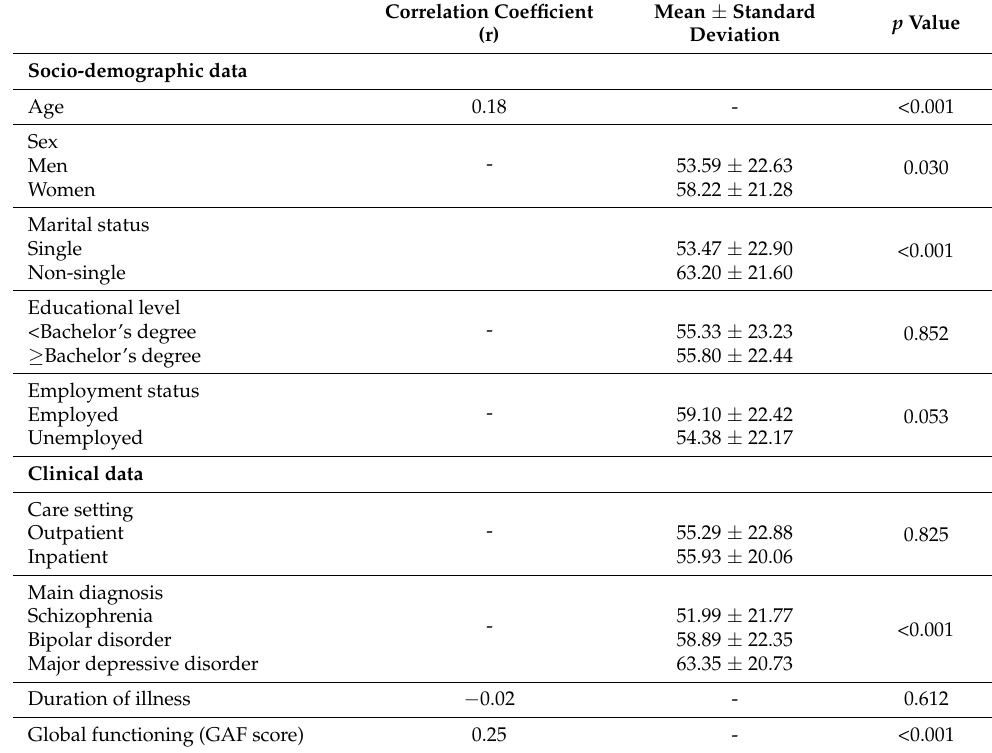
Table 3. Comparison of PREMIUM-RD scores with socio-demographic and clinical data and proxy measures of quality of